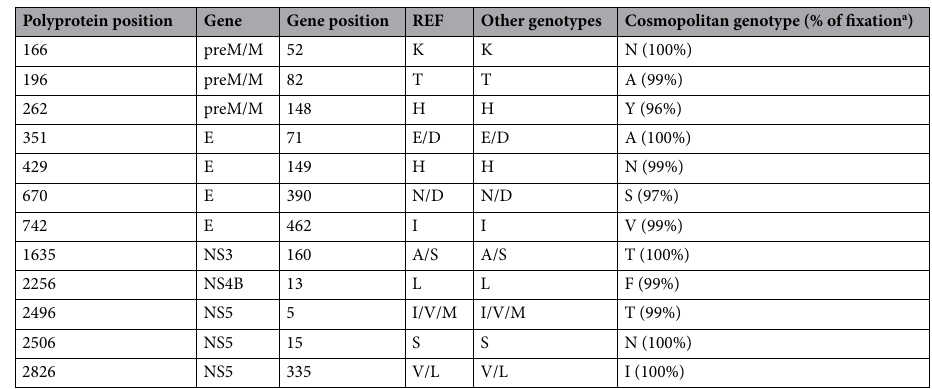
Table 1. Unique amino acid signature of cosmopolitan genotype. a The percentage values indicate the extent of fixation of each mutation in 445 sequences of cosmopolitan genotype as compared to 1,007 sequences of other genotypes of DENV-2. NCBI reference sequence NC_001474.2 was used as the reference (REF) genome. M membrane, NS non-structural proteins, preM